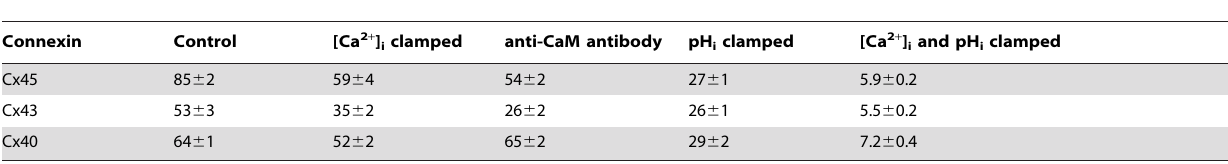
Table 3. % inhibition of junctional conductance (G j ) by oxygen glucose deprivation